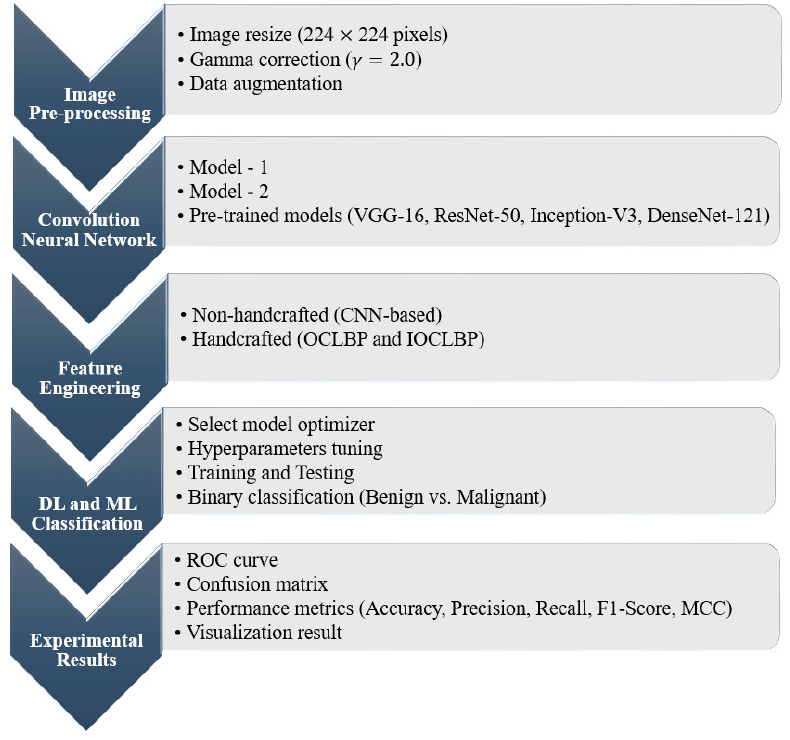
Figure 3. Proposed pipeline for image and feature classification based on a lightweight convolutional neural network (LWCNN) and ensemble machine learning (EML). LR: logistic regression, RF: random forest.